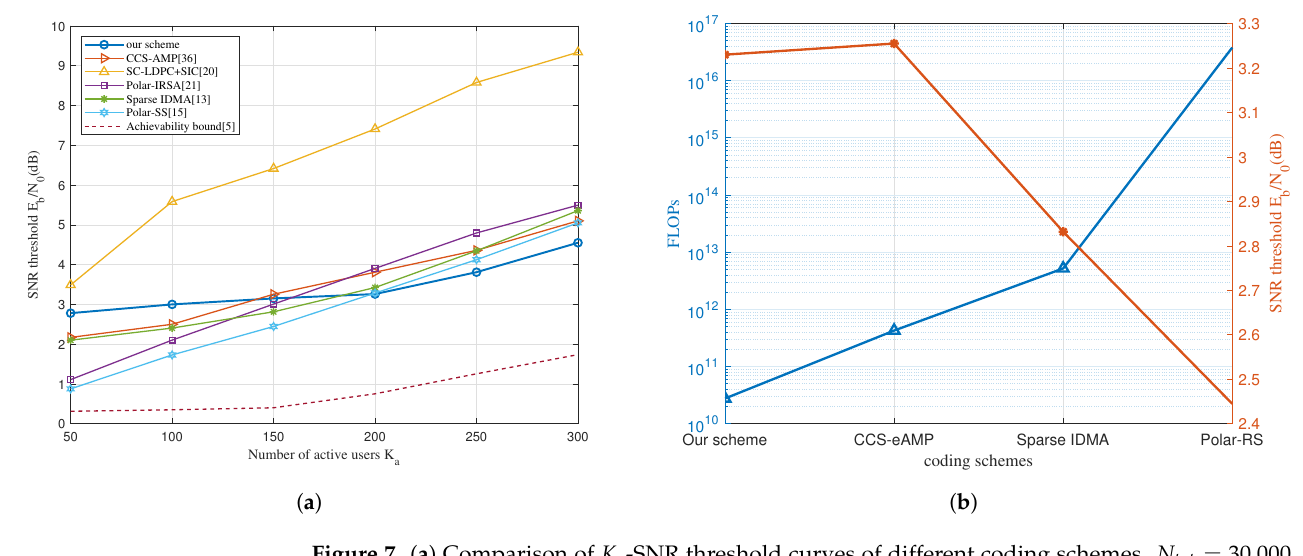
Figure 7. ( a ) Comparison of K a -SNR threshold curves of different coding schemes. N tot = 30,000, B = 100, PUPE = 0.1. ( b ) Performance and computational complexity comparison at N tot = 30,000, B = 100, K a = 150, PUPE =